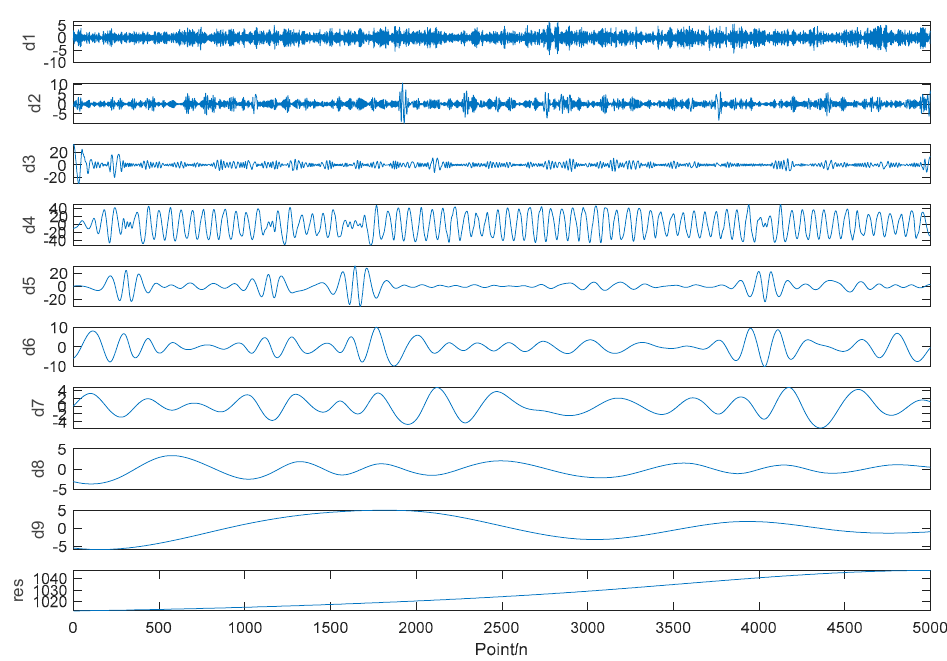
Table 3. Descriptive statistics of mold level.